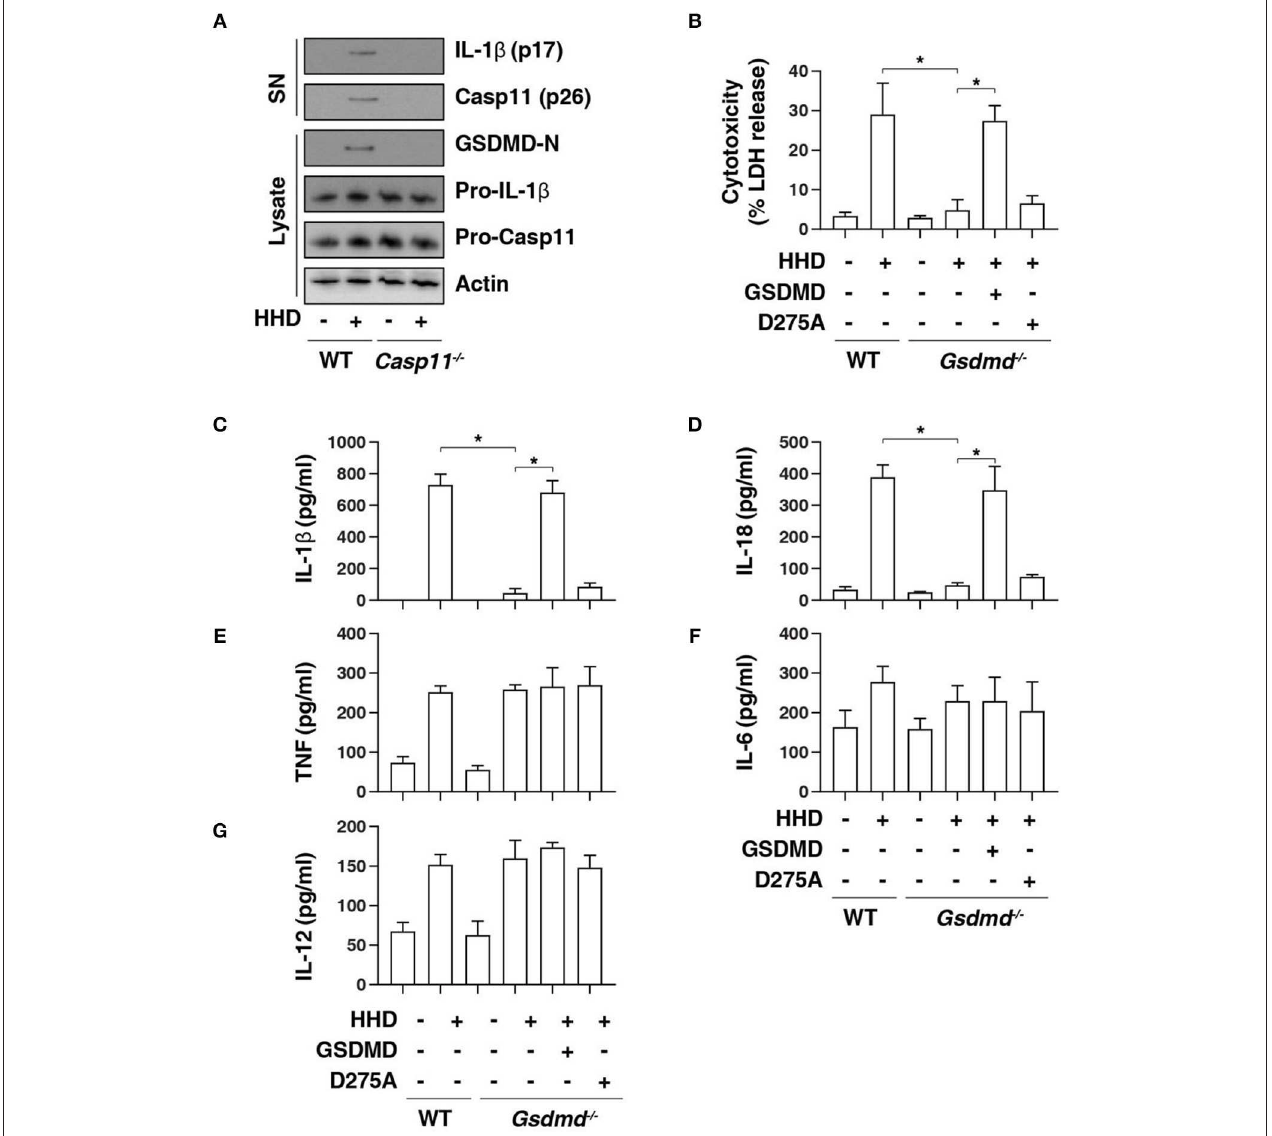
FIGURE 2 | GSDMD is required for nuclear DAMP complex-induced pyroptosis. (A) Western blot analysis of indicated proteins in the supernatant (SN) or cell lysate in indicated LPS-primed BMDMs after HHD treatment (500ng/mL, 16h). (B–G) Analysis of cytotoxicity (B) , IL-1 β (C) , IL-18 (D) , TNF (E) , IL-6 (F) , and IL-12 (G) release in indicated LPS-primed BMDMs after HHD treatment (500ng/mL, 16h) in the absence or presence of the overexpression of GSDMD WT or D275A cDNA. n = 3, data expressed as means ± SD of three independent experiments, * P < 0.05, t test. Western blot data represent two independent